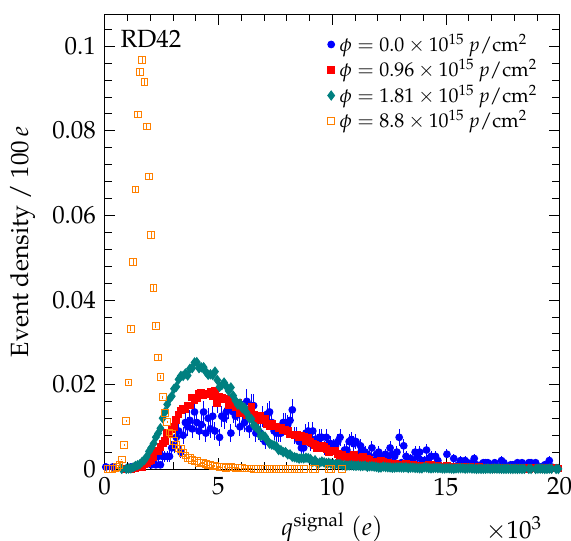
Figure 2. The signal charge spectrum evolution for samples irradiated with 70MeV protons biased at E = + 2V/µm. The pulse height spectrum before irradiation was measured using a setup with a 90 Sr β -source and a single pad metallization on the diamond. The integral of each spectrum has been normalized to unity.